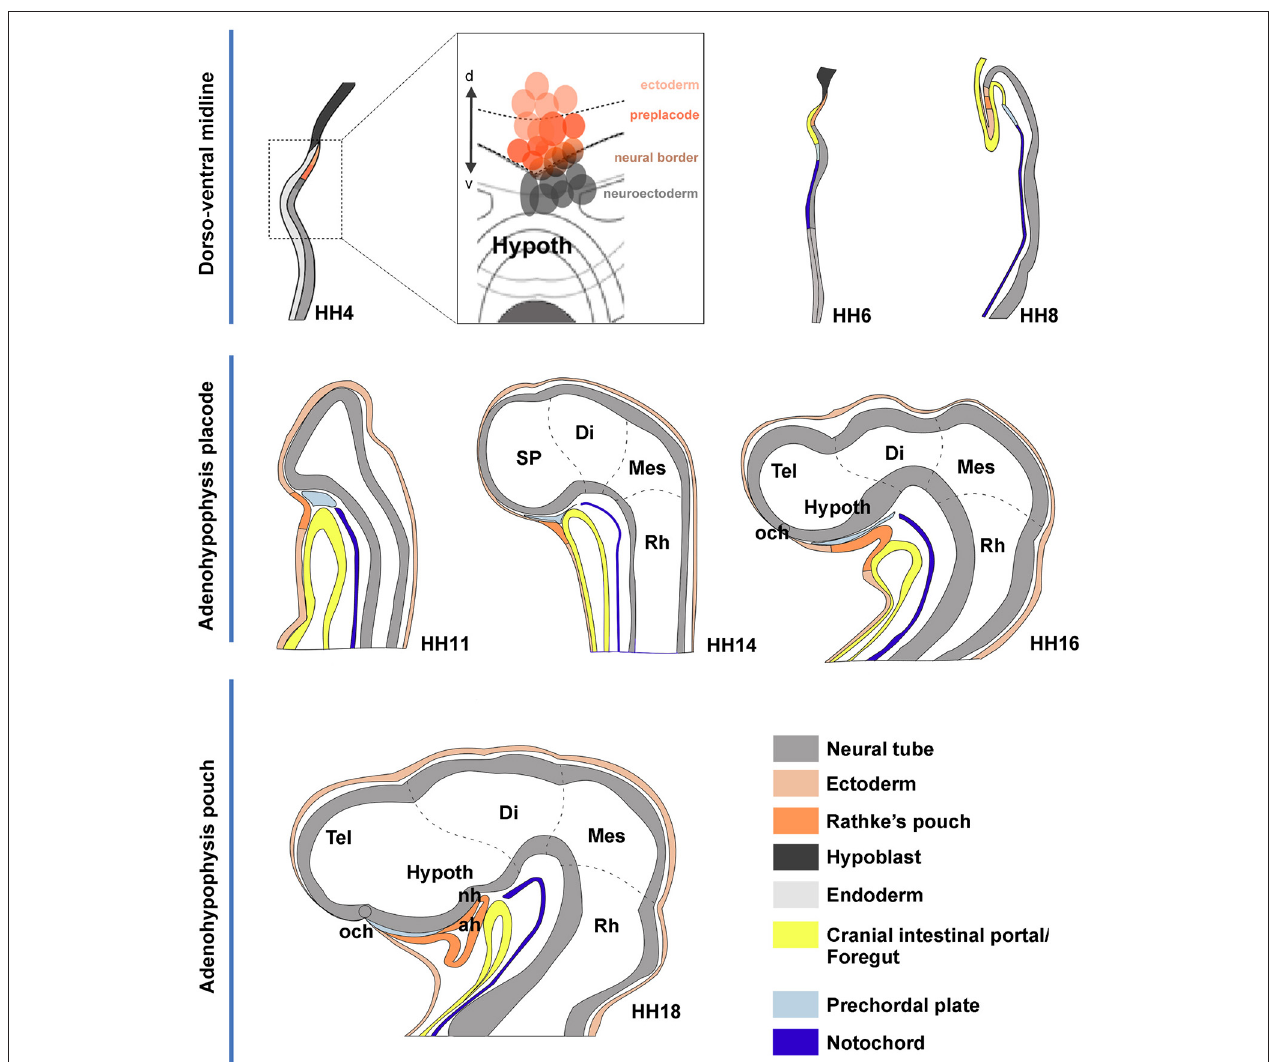
causing the ADH field to flip over in a hinge-like motion under the anterior intestinal portal, though it still remains transiently attached by head ectoderm to the anterior neural ridge (rostral neuropore still open). (HH11) Neurulation is nearly finished at this stage; we identify the head ectoderm (weak orange) and the prechordal plate mesoderm (weak blue) at the tip of the notochord (the latter lies under the prospective mammillary pouch); note the prechordal tissue transiently separates the ADH rudiment from the basal hypothalamus. (HH14,HH16) The prechordal tissue gradually migrates dorsalward in front of the terminal hypothalamic wall, allowing the stomodeum to form and the ADH to approach the hypothalamus. (HH18) The prechordal cells have migrated away, being now in contact with the alar median hypothalamus (chiasmatic region) and the prospective preoptic telencephalon (terminal lamina); they leave the basal tuberal hypothalamus free for close contact with the ADH primordium; this rostroventral tuberal territory includes the prospective neurohypophysis (NH), whose evagination is first observable several stages later, at HH26.